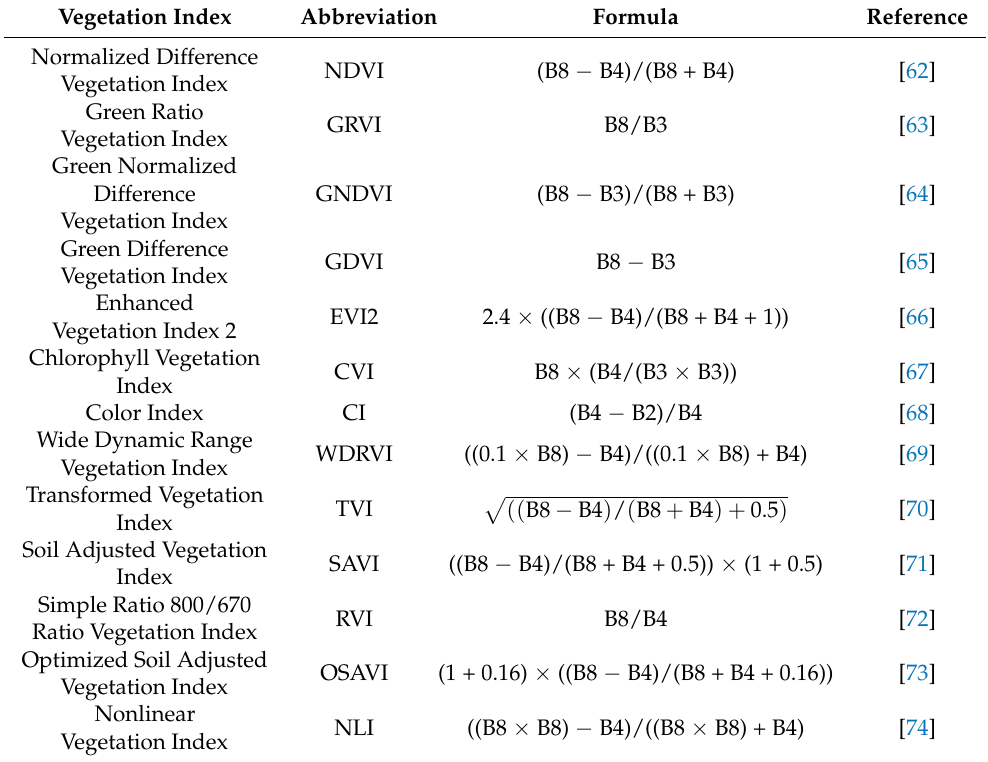
Table 1. Vegetation indices calculated in this study with their formulae according to the S2 bands used. Vegetation